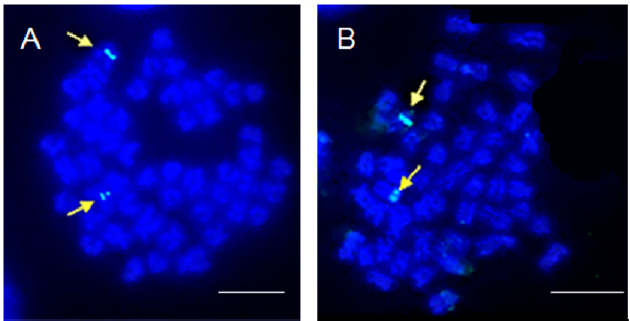
Figure 5. Mitotic metaphase plates of ( A ) Onychostoma barbatulum and ( B ) O. alticorpus chromosomes after fluorescence in situ hybridization (FISH) with 5S rDNA probes. Arrows indicate the locations of 5S rDNA loci (light blue). Bars equal 5 μ m.